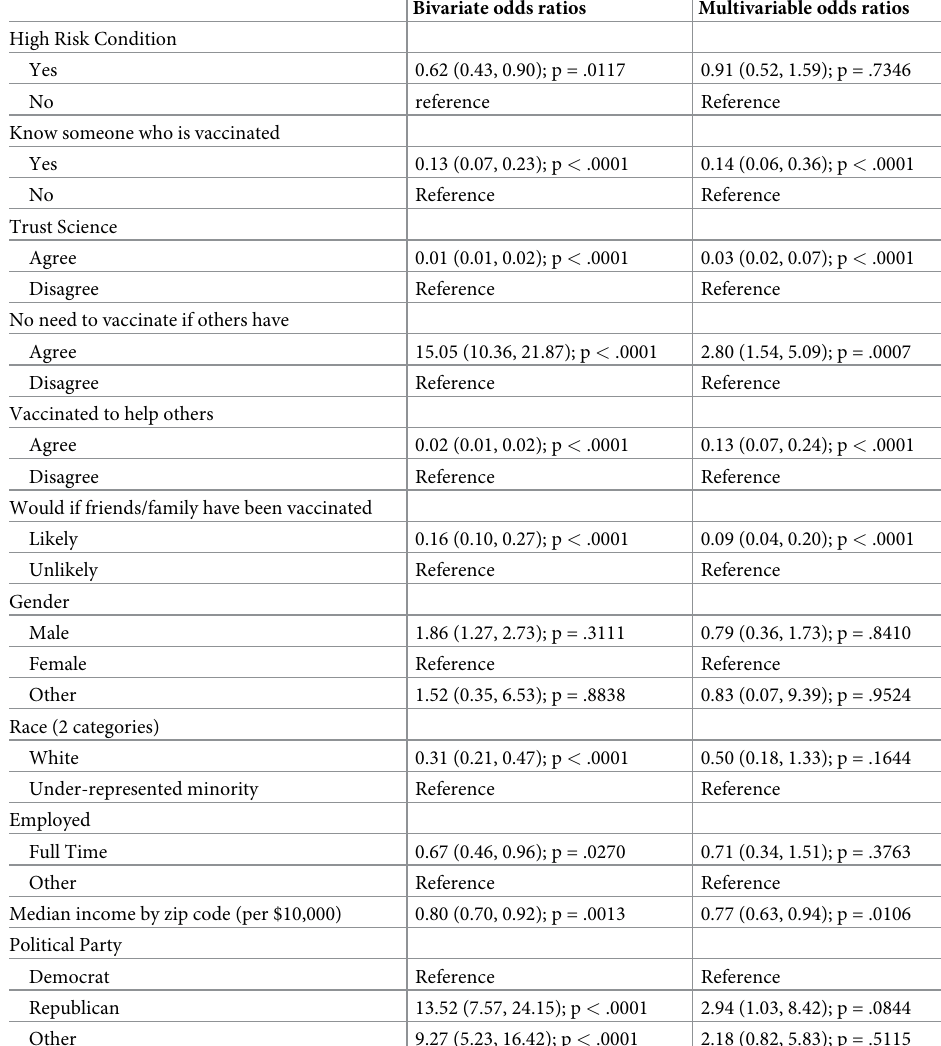
Table 4. Association of population characteristics with either acceptance or rejection of vaccines. Bivariate odds ratios Multivariable odds ratios